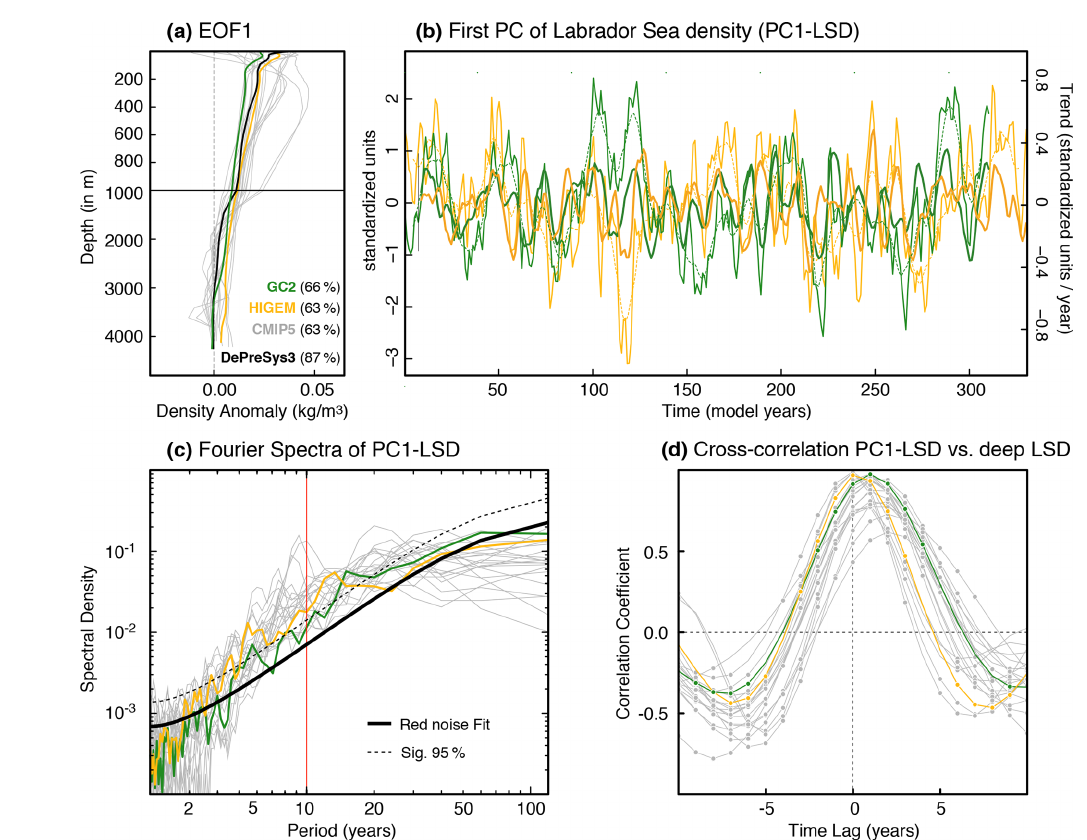
Figure 2. (a) First empirical orthogonal function (EOF) as a function of depth of the spatially averaged LSD in all the preindustrial exper- iments and in the DePreSys3 assimilation run. The percentage of variance explained by this mode in each model is included in brackets in the legend (for the CMIP5 runs, this represents the mean value across the ensemble). Because the sign of an EOF is arbitrary, it has been adjusted for all models (together with the sign of the respective principal component) so that both represent an increase in density stratifica- tion. (b) Associated principal component of the spatially averaged LSD (PC1-LSD) in the two high-resolution experiments. The thin solid lines represent the raw yearly resolved PC1-LSD time series, the thin dashed lines their respective 10-year running means, and the thick (and slightly darker) lines their associated 10-year running trends (centred around the last year of the decade over which the trend is computed). (c) Normalized Fourier spectra of the PC1-LSD index in each of the preindustrial simulations. The black thick line represents a red noise process with the same first autoregressive (AR1) coefficient as PC1-LSD in GC2, and the dashed line sets the 95% confidence interval of this red noise process. No major differences are found when using HiGEM’s AR1 coefficient instead. The red vertical line highlights the 10-year periodicity to separate the interannual from the decadal to multidecadal timescales. (d) Lead–lag correlations between the decadal trends in PC1-LSD and those in the deep LSD index from Robson et al. (2016), defined as the 1000–2500m average density in the box 60–35 ◦ W, 50–65 ◦ N. Positive lags indicate that PC1-LSD leads the changes in deep LSD. Full dots denote correlation values exceeding a 95% confidence level based on a Student’s t test that takes into account the series